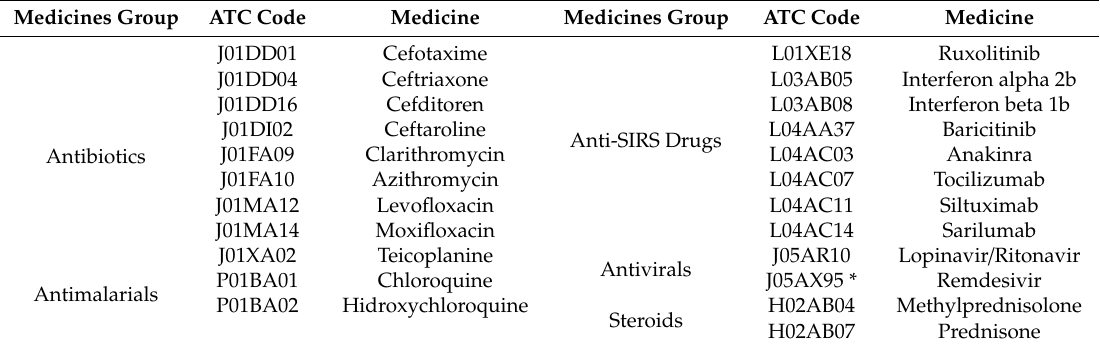
Table 5. List of medicines used in the COVID-19 treatment according to Spanish guidelines [17,18]. Medicines Group